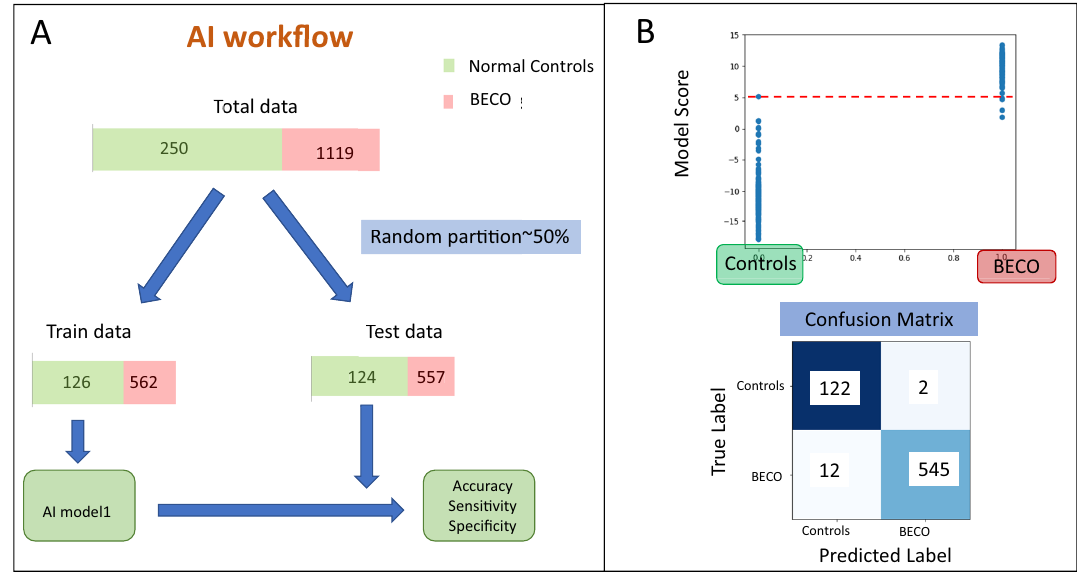
Figure 5. AI workflow for distinguishing BECO cancers from normal controls and its application. Panel A depicts the AI workflow employed to test the AI model for distinguishing between the women-specific cancer group (BECO) from the Normal controls. Panel B depicts the results from testing of the trained model for distinguishing women-specific cancers (BECO) from normal controls showing clear separation of disease. The separation achieved between the cancer and the control group is shown in the form of a confusion matrix, with the resulting sensitivity and specificity values also given.